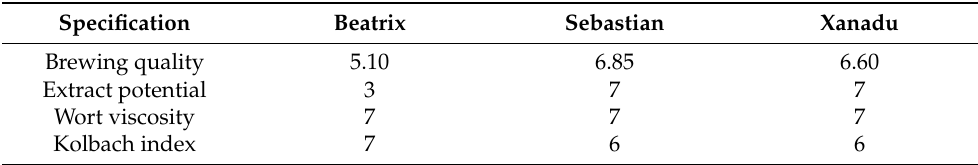
Table 1. Details of the three selected varieties of